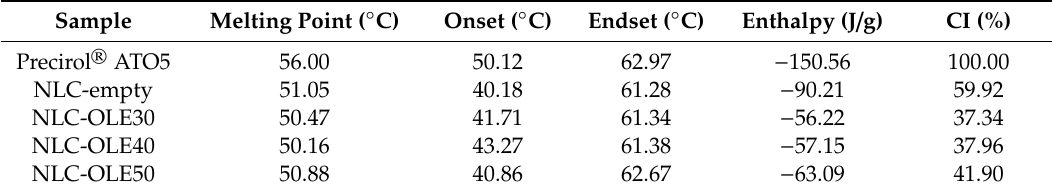
Figure 2. Di ff erential scanning calorimetry (DSC) graphs of pure excipients (D-trehalose, Poloxamer Figure 2. DSC graphs of pure excipients (D-trehalose, Poloxamer 188, Precirol ATO 5, 188, Precirol ATO 5, oleuropein (OLE), developed nanoparticles with OLE (NLC-OLE30, NLC-OLE40, Oleuropein), developed nanoparticles with oleuropein (NLC-OLE30, NLC-OLE40, NLC-OLE50) NLC-OLE50), and without OLE (NLC-empty). and without oleuropein (NLC-empty). Table 3. Thermal properties of Precirol and nanoparticles (NLC-empty, NLC-OLE30, NLC-OLE40, and